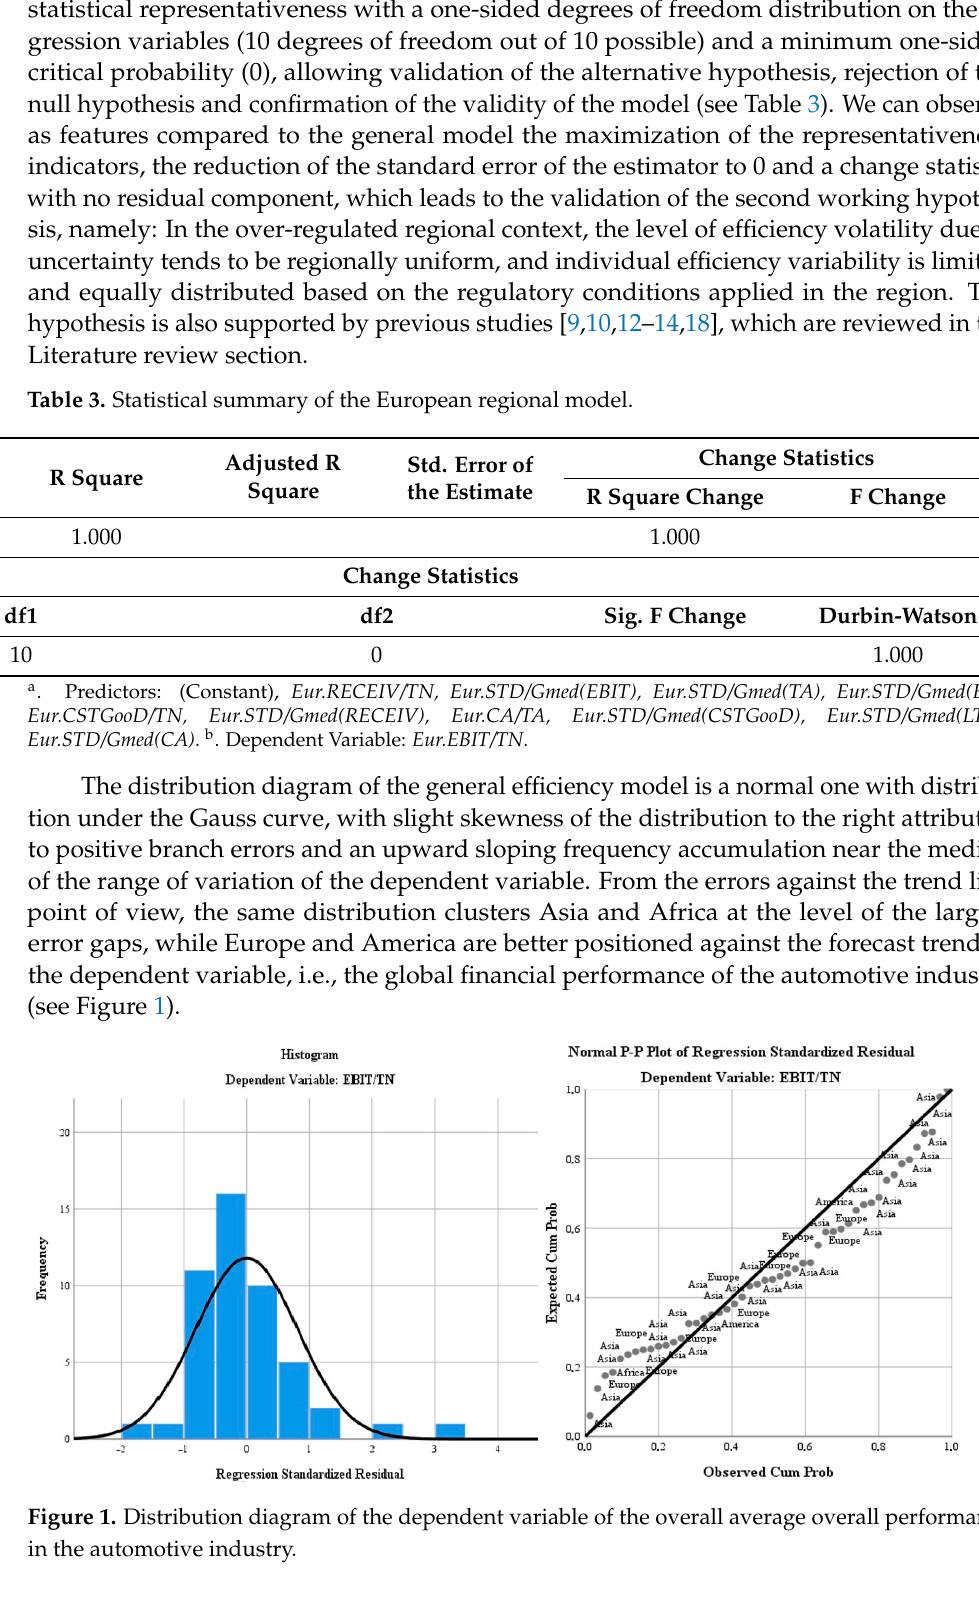
Table 4. Unstandardised Coefficients Model.